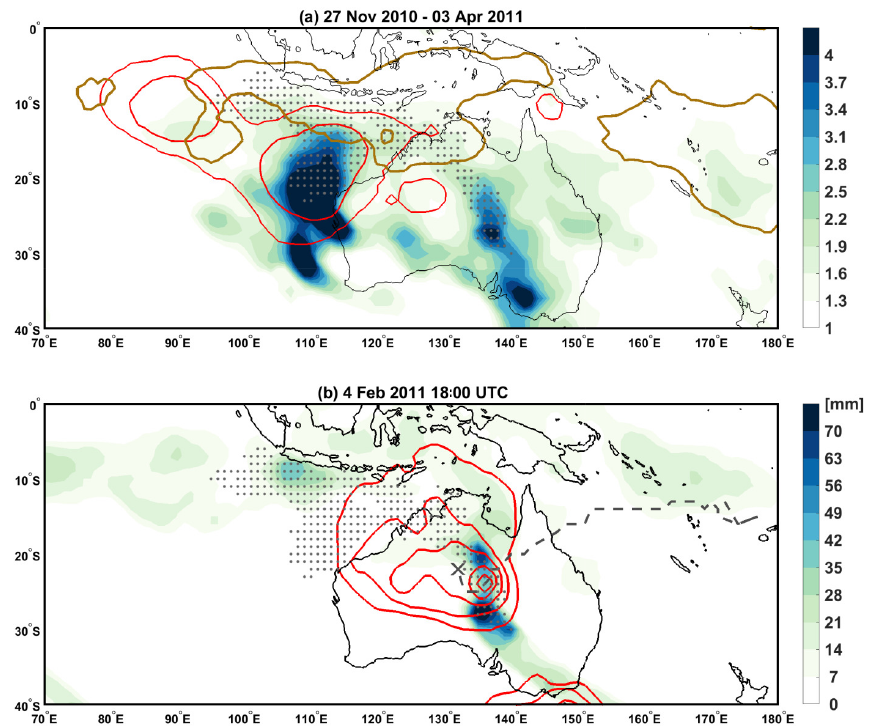
Figure 9. (a) Ratio of accumulated precipitation during the period 27 November 2010 to 3 April 2011 with respect to climatological values for the same time period (in color) for an extreme wet season patch affecting Australia (dotted area). Red (brown) contours show areas with positive anomalies of cyclone (RWB) occurrences with respect to climatology (shown are anomalies of 10% and 20% for cyclones and 20% for RWB). (b) 24h accumulation of precipitation from 18:00UTC on 3 February to 18:00UTC on 4 February 2011 (in color). Red contours show sea level pressure at 18:00UTC on 4 February 2011 (starting from 1006hPa and with steps of − 2hPa). The grey dashed line shows the track of Tropical Cyclone Yasi, while its position of cyclolysis is represented by the cross